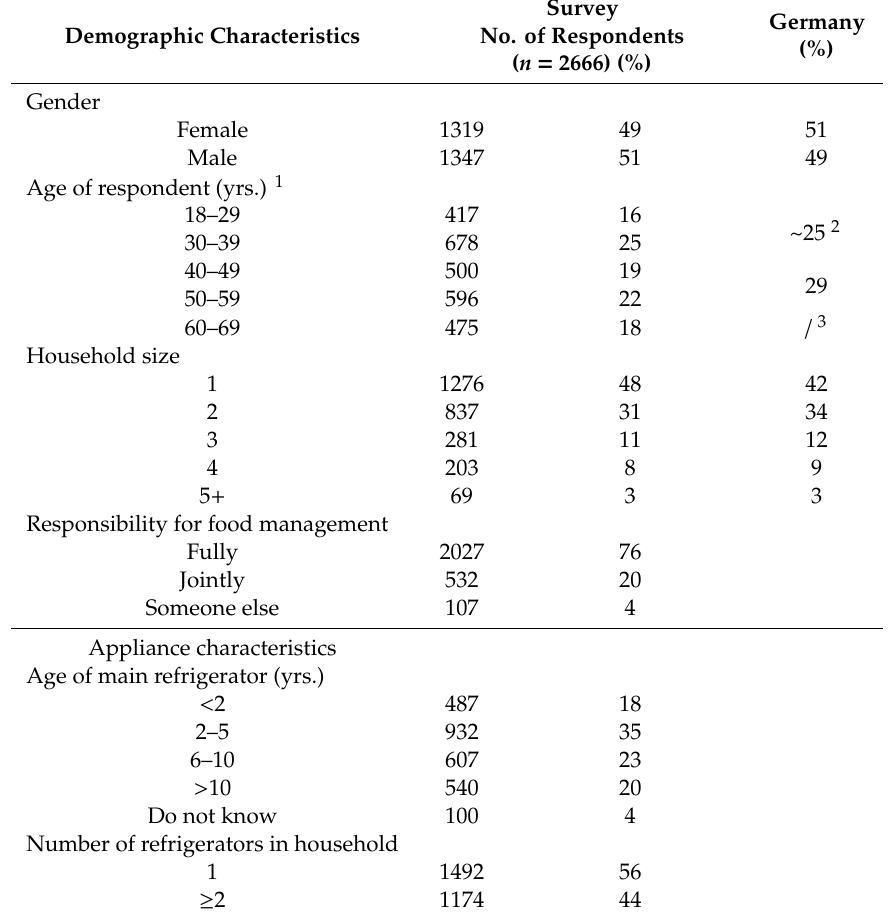
Table 1. Number and percentages of demographic and refrigerator characteristics from surveys’ respondents (multiple-choice, single-answer). The data of the population distribution in Germany, 2018, are given as a reference [37–39].